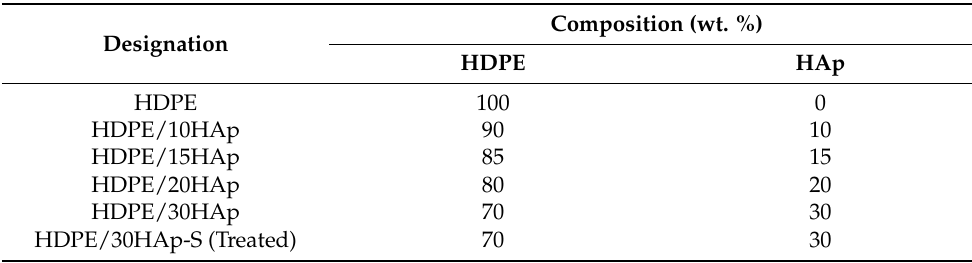
Table 1. Composition and designation of high-density polyethylene/hydroxyapatite (HDPE/ HAp)